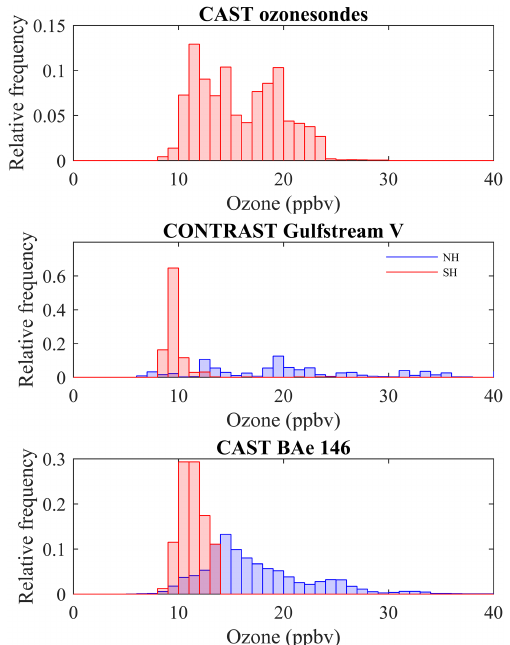
Figure 20. Histograms of ozone concentrations in the lowest 100hPa from CAST ozonesondes, CONTRAST Gulfstream V and the CAST FAAM BAe 146 aircraft, split into Northern Hemisphere data (blue) and Southern Hemisphere data